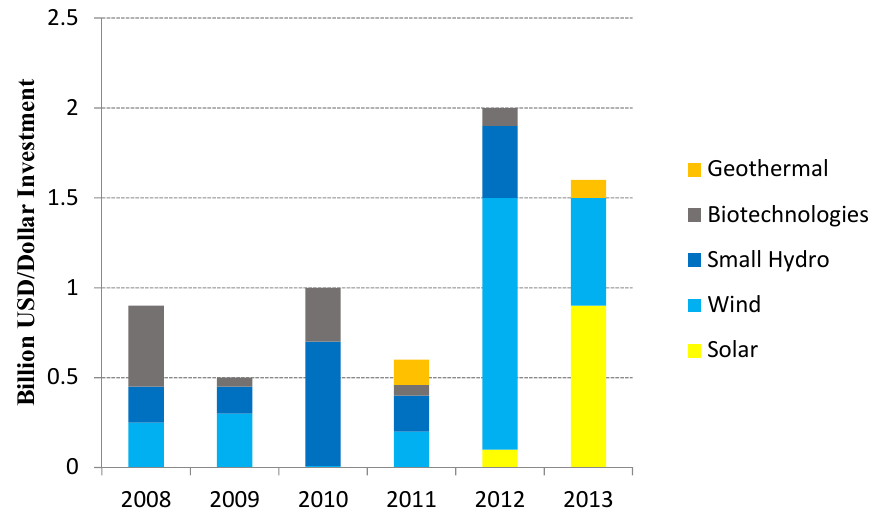
Figure 2. Annual renewable energy investments in Chile between 2008 and 2013. Source: [36].